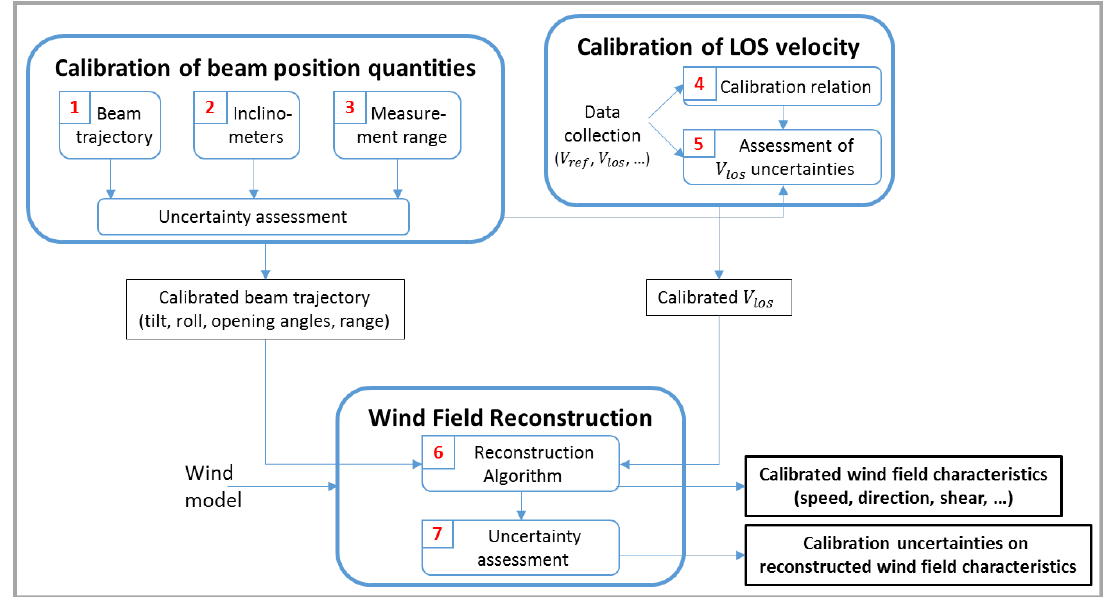
Figure 3. Schematic of the white box calibration concept for wind